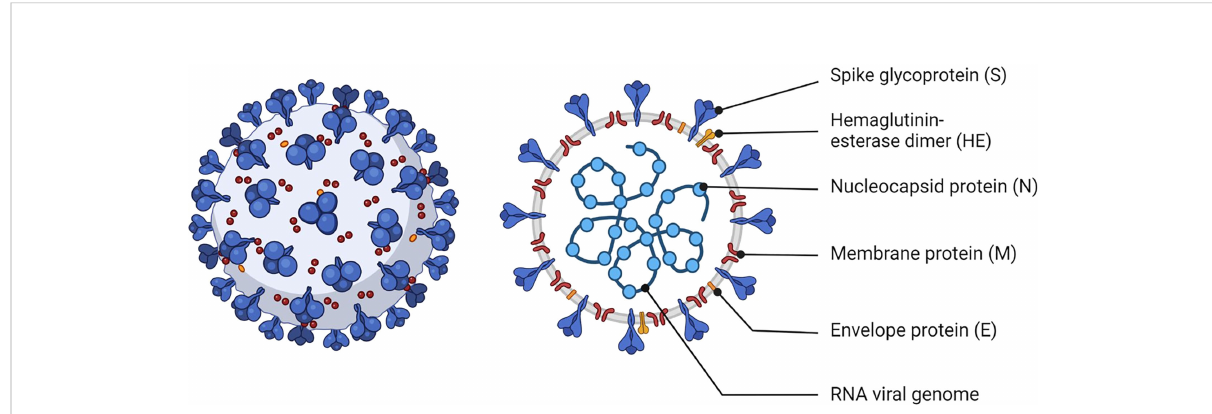
FIGURE 1 Schematic of SARS-CoV-2. The viral RNA is contained within the viral envelope, a lipid bilayer derived from the host cell membrane. Structural proteins such as spike (S), membrane (M), envelope (E) proteins are embedded in the viral envelope. The S protein is essential for the virus to attach to and enter uninfected cells. Created with